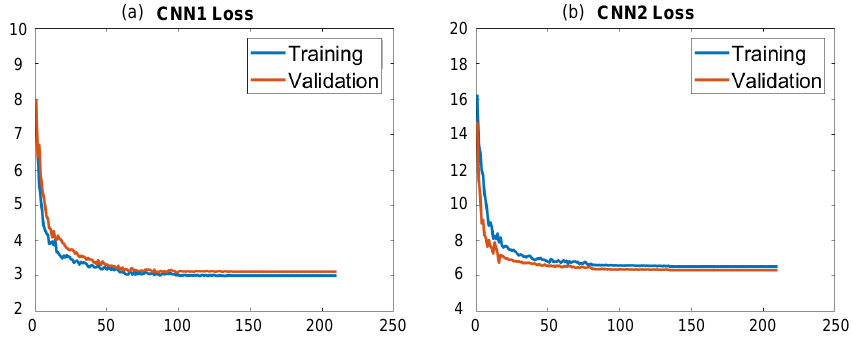
Figure 4. The loss curve of ( a ) CNN1, ( b ) CNN2.